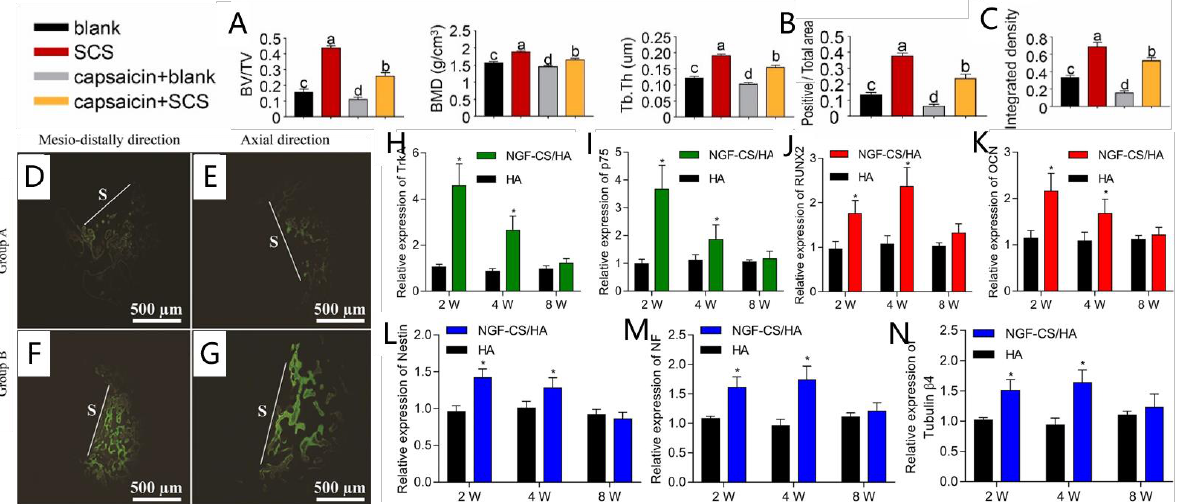
Figure 4. Surface alteration influences osseointegration and innervation. ( A – C ): Through sensory nerve innervation, SCS stimulates bone repair [205]. ( A ) The SCS group had substantially greater BV/TV, Tb, Th, and BMD values than the other three groups; ( B ) Von Kossa staining; and ( C ) in vivo calcein labeling. ( D – G ): Using the CTAN software tool, 3D pictures of beagle maxilla samples were created to assess bone development in tooth defects [206]. The fluorochrome labeling of calcein (green) injected on week 2 consistently demonstrated that group B animals ( F , G ) had more bone regeneration than group A animals ( D , E ). ( H – N ): NGF, osteogenesis differentiation, and neurogenic differentiation-related genes were significantly elevated when NGF-CS/HA-coating implants were implanted [207]. RT-qPCR analysis of Trk A and p75 ( H , I ); OCN and Runx-2 ( J , K ); and Nestin, NF, and tubulin β4 ( L – N ) in HA- and NGF-CS/HA-coating implant groups at 2, 4, and 8 weeks. * p < 0.05. Different lowercase letters indicate significant differences.